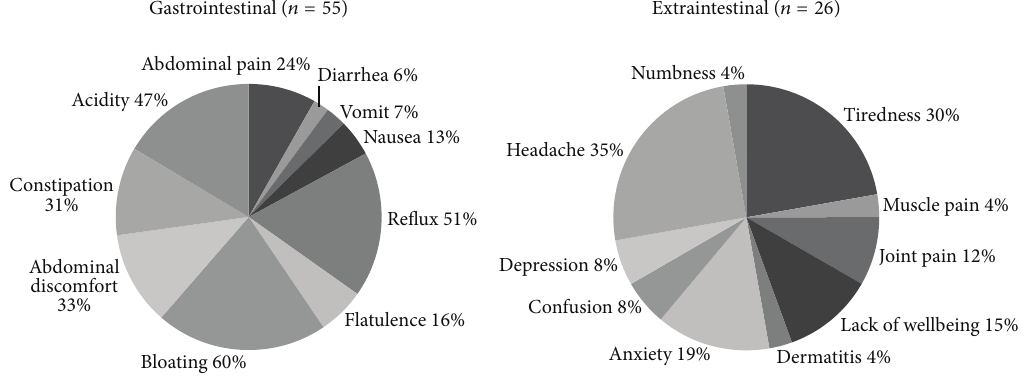
Figure 3: Self-reported NCGS